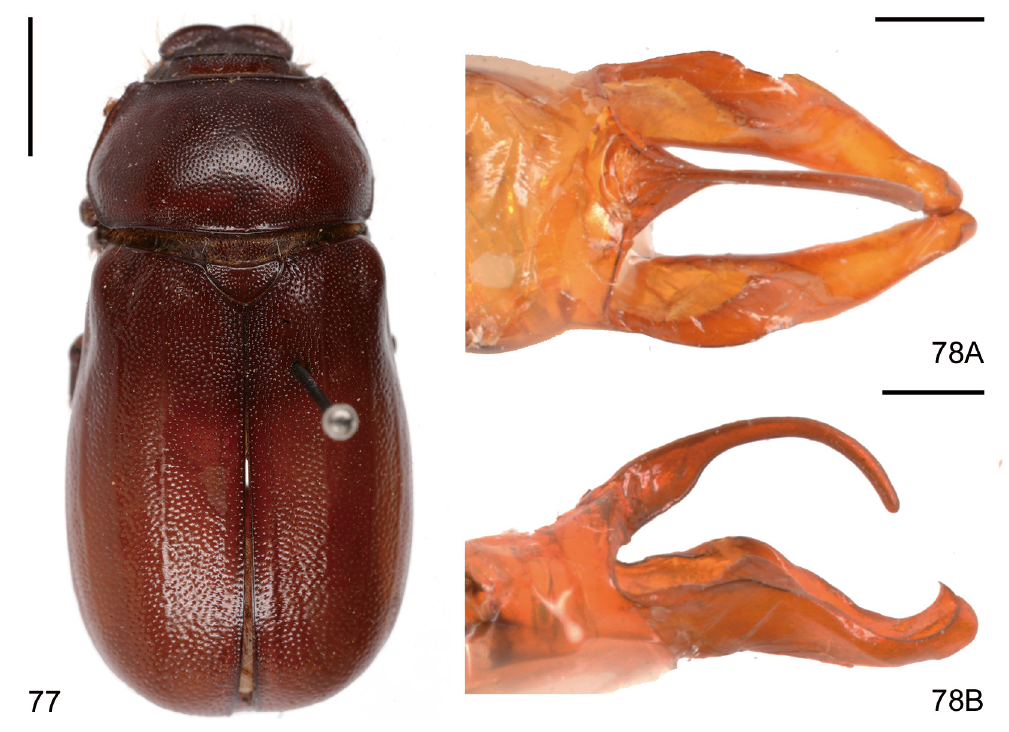
Figs 77–78. Miridiba vethi (Moser, 1917), lectotype, ♂ (MFNB). 77 . Habitus in dorsal view. 78 . Parameres in dorsal (A) and lateral (B) views. Scale bars: 77 = 5.0 mm; 78 = 1.0